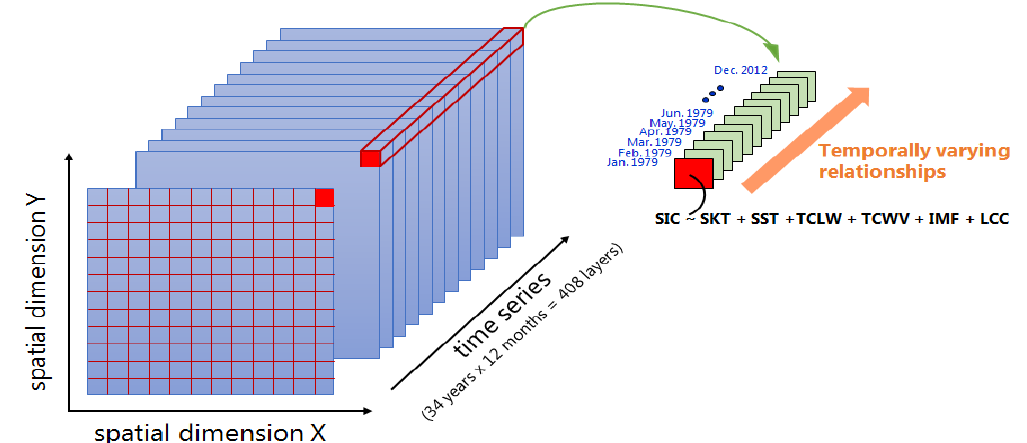
Figure 9. Conceptual framework of the ARIMA models to incorporate temporally varying relationships between sea ice concentration and climate variables.